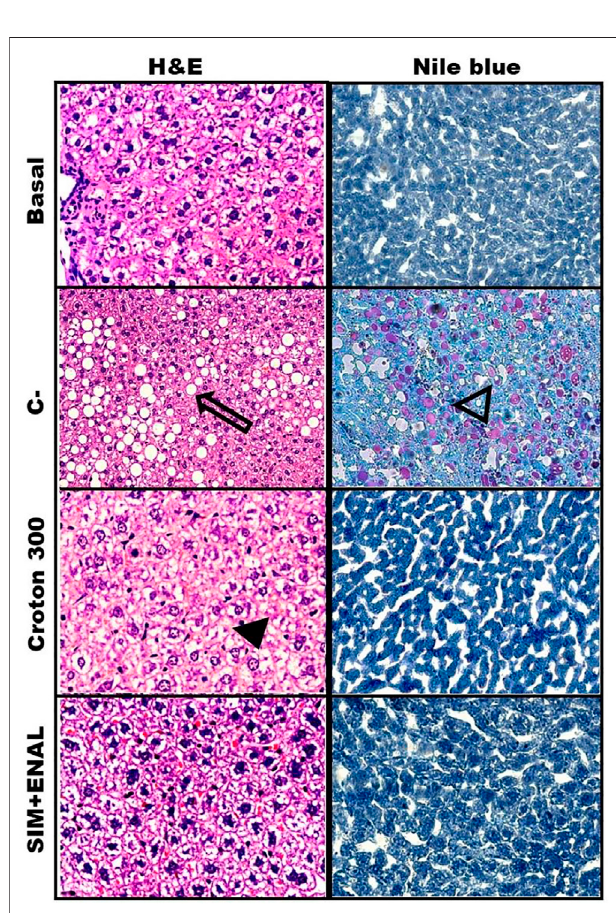
FIGURE 4 | Histopathological hepatic analysis. Livers from normotensive, non-dyslipidemic, and non-smoker rats (basal group) and hypertensive, dyslipidemic, and smoker spontaneously hypertensive rats that were treated with vehicle (negative control [C-]), 30 mg/kg Croton urucurana extract(Croton30),orsimvastatin+enalapril(SIM+ENAL),stained withhematoxylin/eosin(A&E)orNileBlue.Theblackarrowindicatessteatosis. The open arrow indicates lipids droplets. The black arrowhead indicates